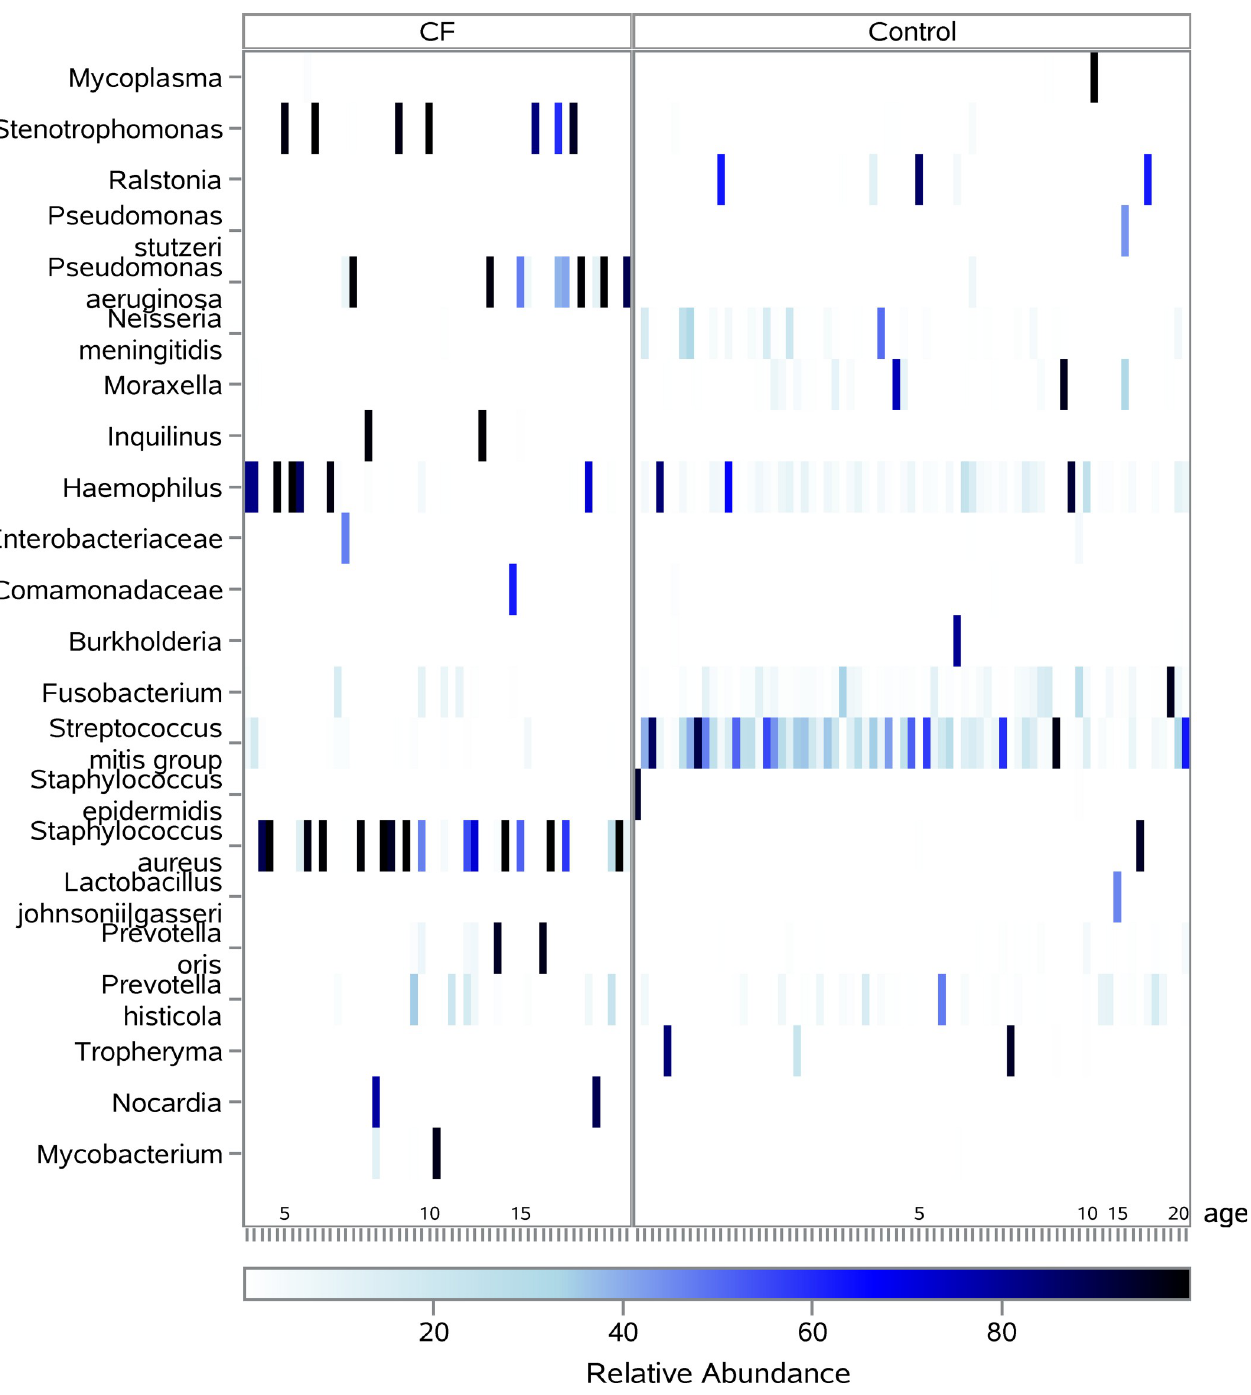
Fig 3. Relative abundance across age. Heatmap of sequencing results for all BALF samples in CF and DC groups with samples arranged in order of increasing age (in years). Taxa that had a relative abundance of over 40% in at least one of the samples are included. Clear distinctions in microbiota across the age spectrum are seen, with any taxa identified in high relative abundance in CF samples being seen in low relative abundance in DC samples ( Staphylococcus aureus , Stenotrophomonas ) and any taxa observed in low relative abundance in CF samples seen in high abundance in DC samples ( Streptococcus mitis group).